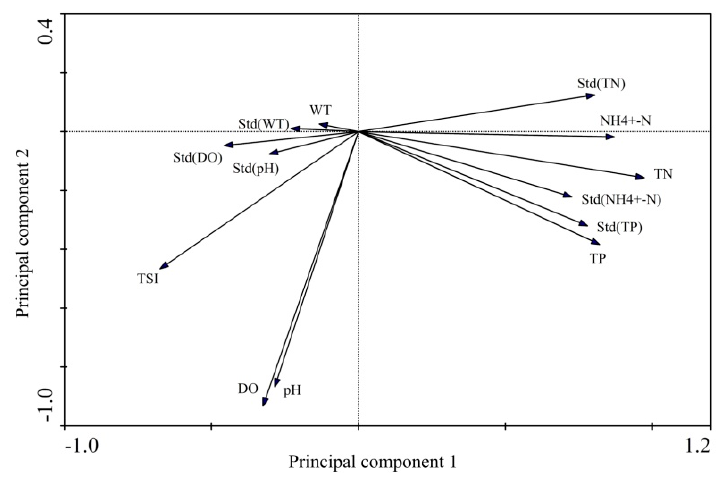
Figure 9. Principal components analysis (PCA) biplot for the relationships between environmental factors and phytoplankton stability (TSI).